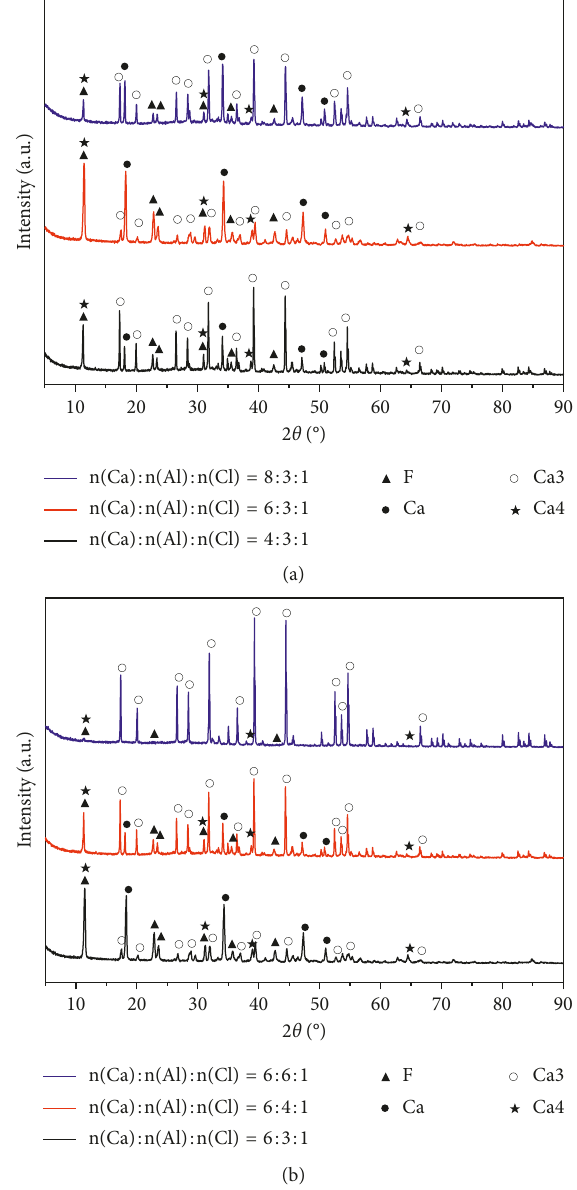
Figure 3: XRD patterns of precipitated solids: (a) different Ca(OH) dosage; (b) different NaAlO 2 dosage. F(Ca 4 Al 2 Cl 2 (OH) 12 ), Ca3 (Ca 3 Al 2 (OH) 12 ), Ca4(Ca 4 Al 2 (OH) 14 ), Ca(Ca(OH) 2